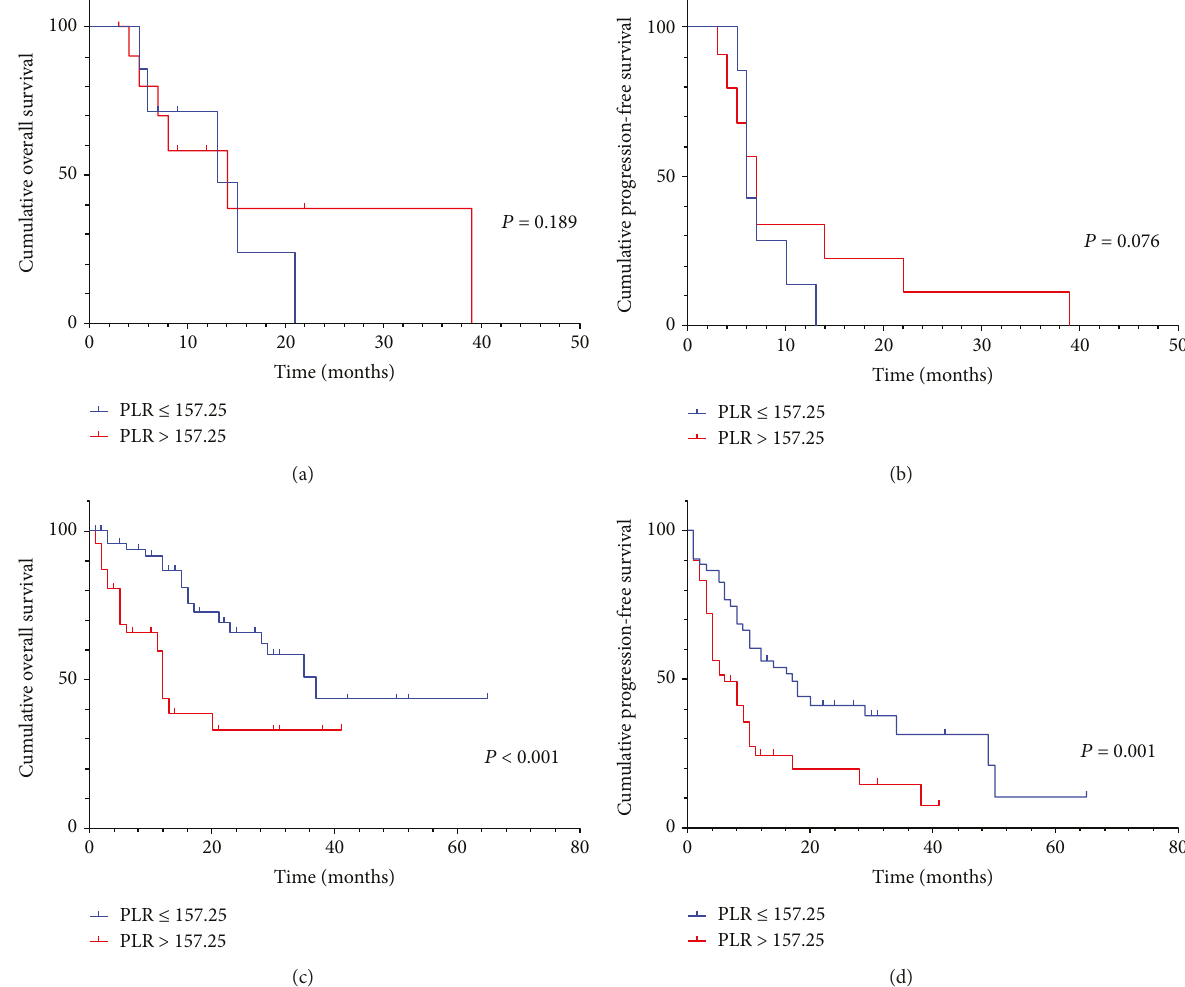
Figure 4: (a, b) Kaplan – Meier curve for OS and PFS of 18 positive lymphatic metastasis patients strati fi ed by PLR. (c, d) Kaplan – Meier curve for OS and PFS of 101 negative lymphatic metastasis patients strati fi ed by